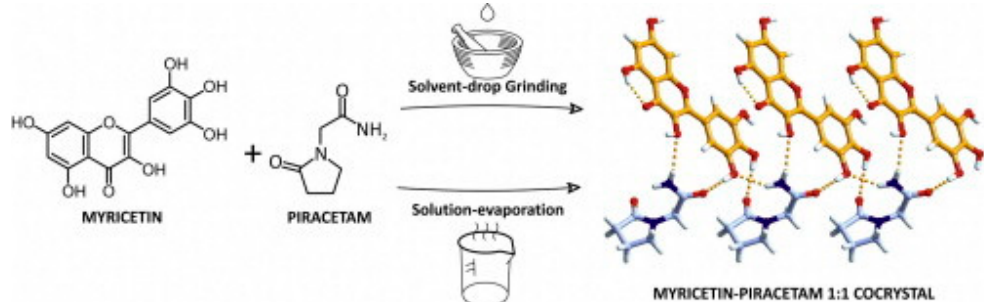
Figure 33. Schematic diagram showing the two drug molecules myricetin and piracetam, resulting in a 1:1 cocrystal structure using both liquid assisted grinding and solution crystallization. Adapted with